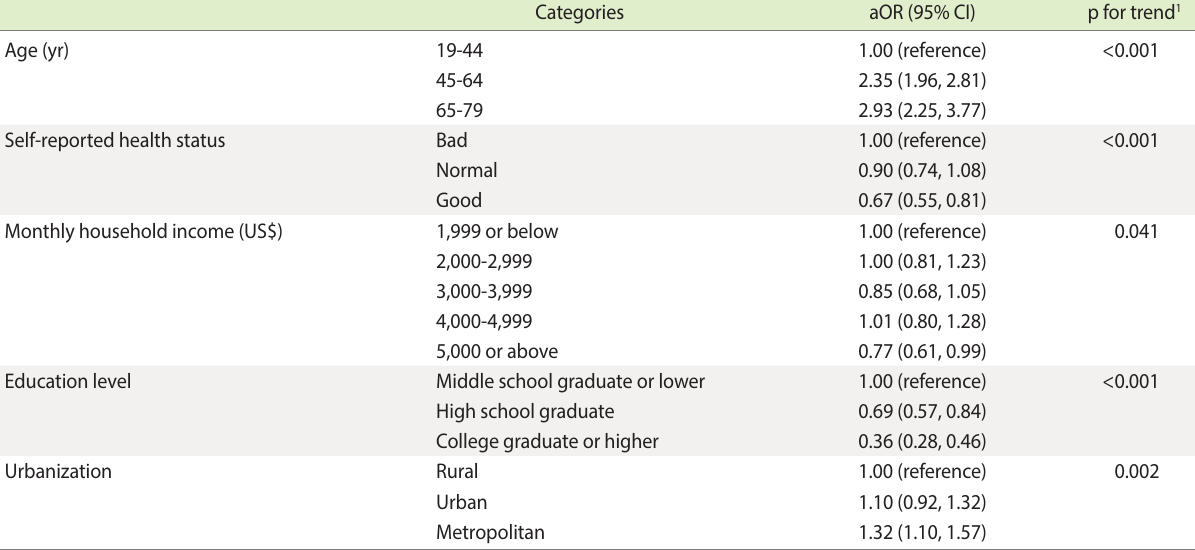
Table 2. Logistic analysis of socioeconomic factors and obesity status in Korea, 2016 (n= 9,000)